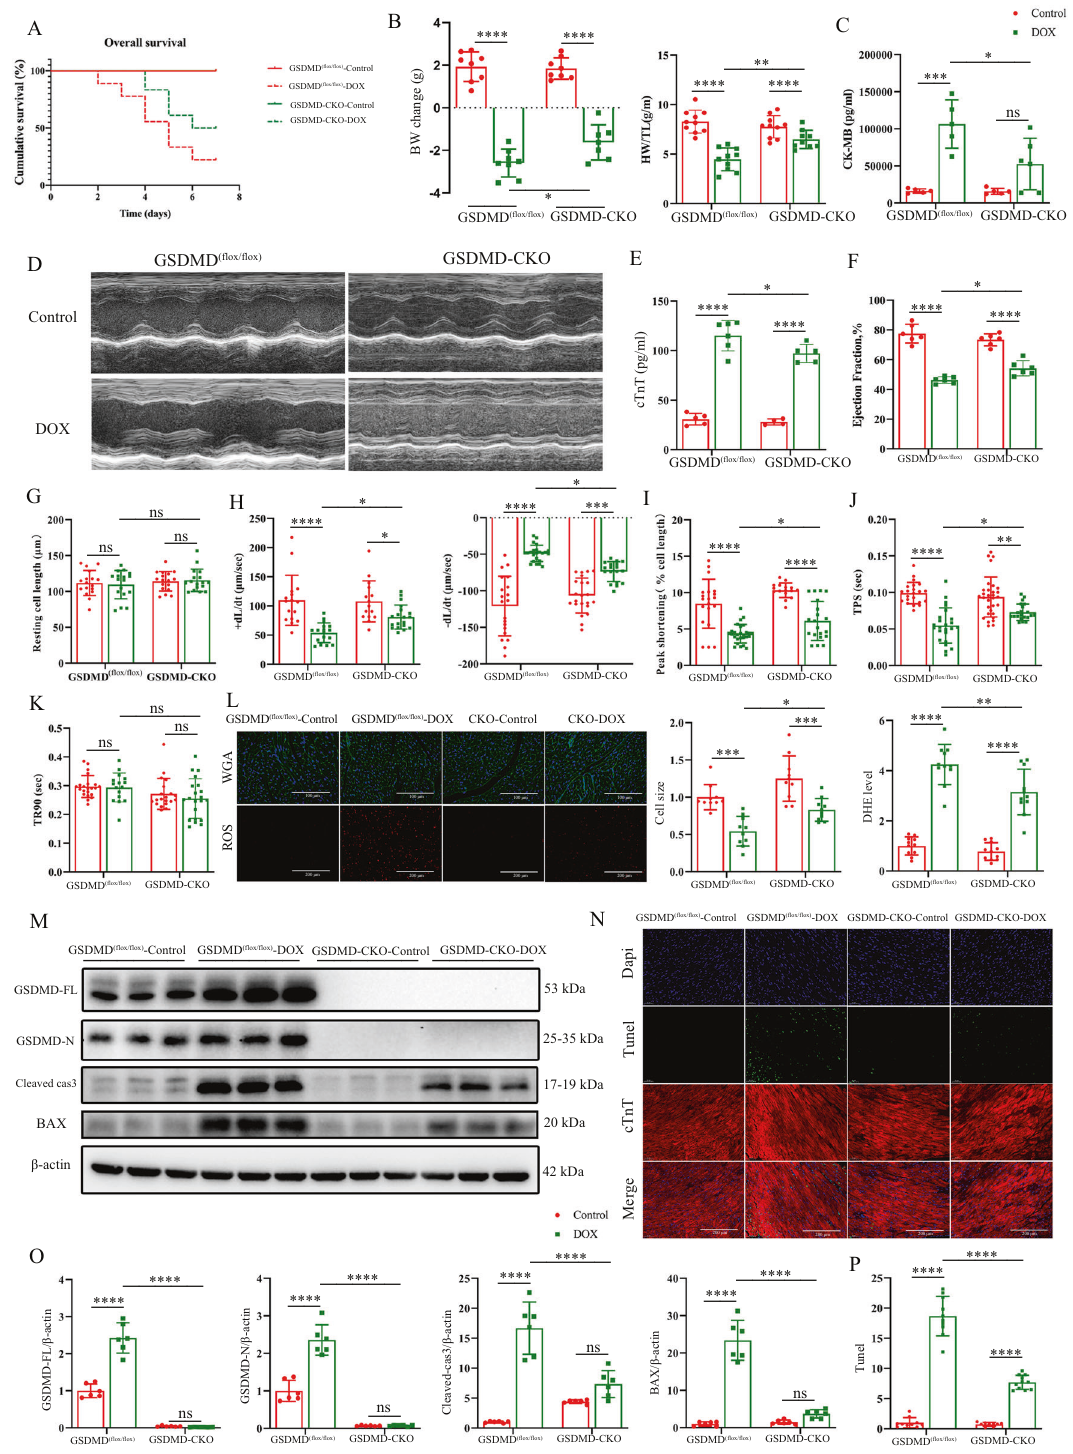
a role in DIC by mediating cardiomyocyte apoptosis, we selected 12 h of DOX treatment as the time point for the subsequent study. GSDMD de fi ciency alleviates DIC and GSDMD overexpression aggravates DIC To explore the biological function of GSDMD in acute animal models of DIC, we established GSDMD-de fi cient mice. DOX injection led to a high mortality among WT mice, and